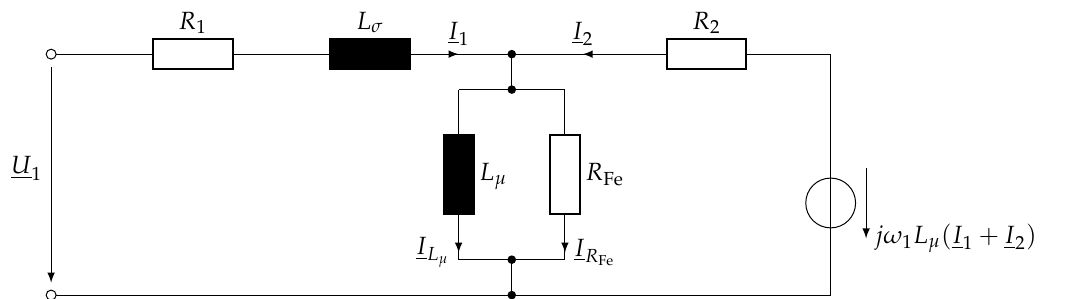
Figure 1. Γ -inverse equivalent circuit of an induction machine including iron